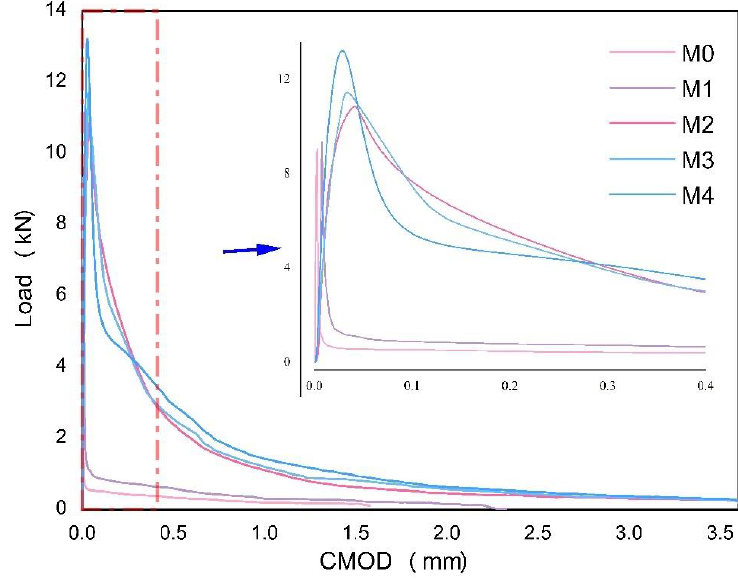
Figure 5. The Load-CMOD curve of the bending test (3.5 mm and 1.0 mm).